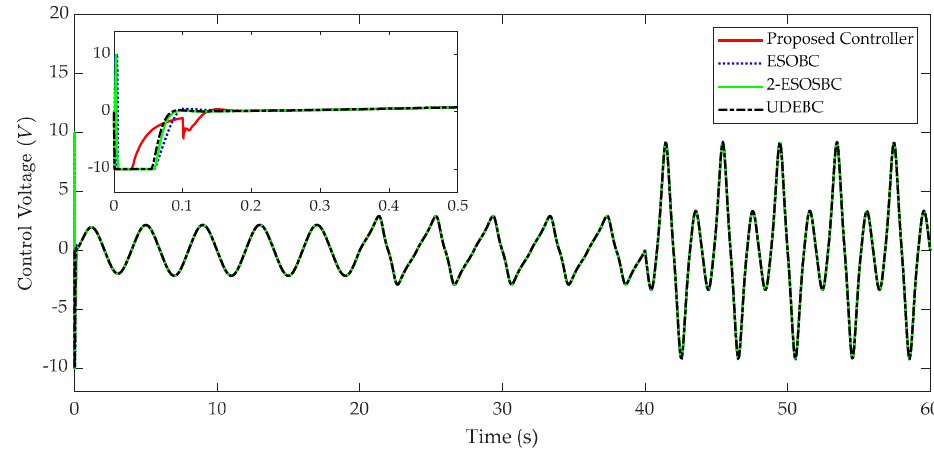
Figure 11. The control actions of considered controllers.